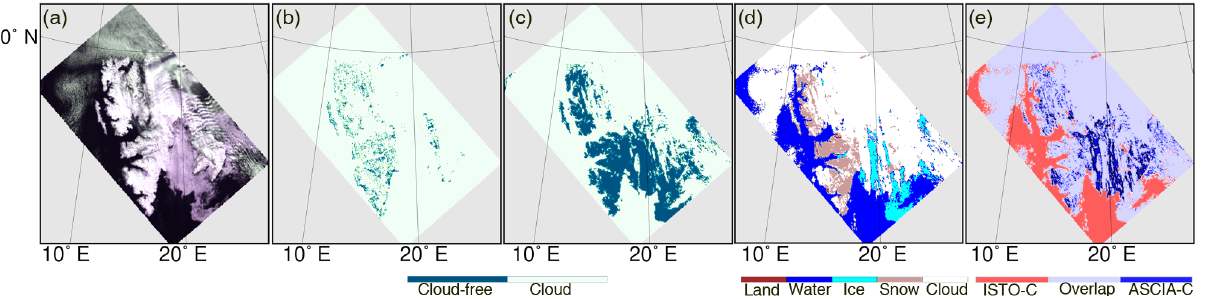
Figure 7. (a) The RGB false-colour image (using 0.67, 0.87 and 0.55µm channels) of AATSR over Svalbard, 10 May 2006; (b) nadir cloud flag from the AATSR L2 product, (c) cloud detection based on the spectral shape of clear snow, (d) cloud detection of ASCIA and (e) the difference between ISTO and ASCIA.